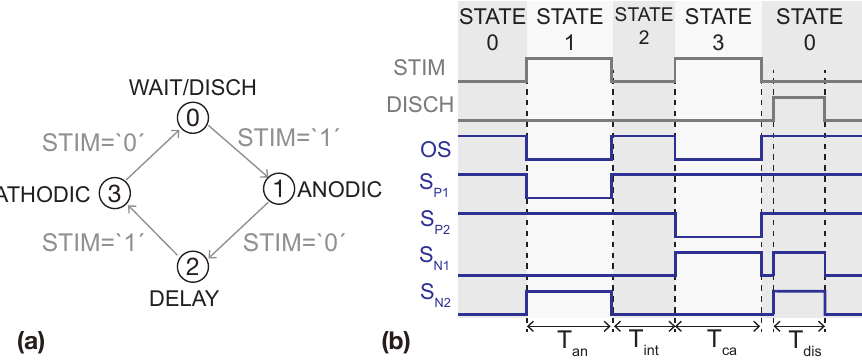
Figure 9. ( a ) Mealy’s state machine implemented for driving the H-bridge. ( b ) Timing diagram of signals generated by the H-bridge